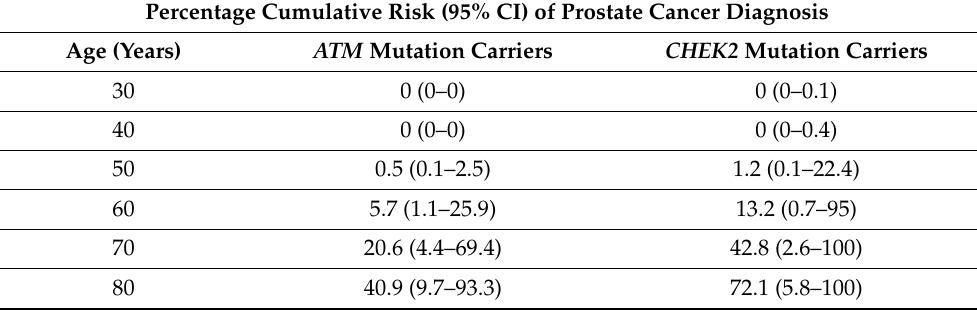
Figure 1. Survival time in years following prostate cancer diagnosis; red line represents survival of ATM mutation carriers following diagnosis, blue line represents survival of BRCAX cohort patients. Table 3. Cumulative Risk of Prostate Cancer Diagnosis for ATM and CHEK2 mutation carriers.